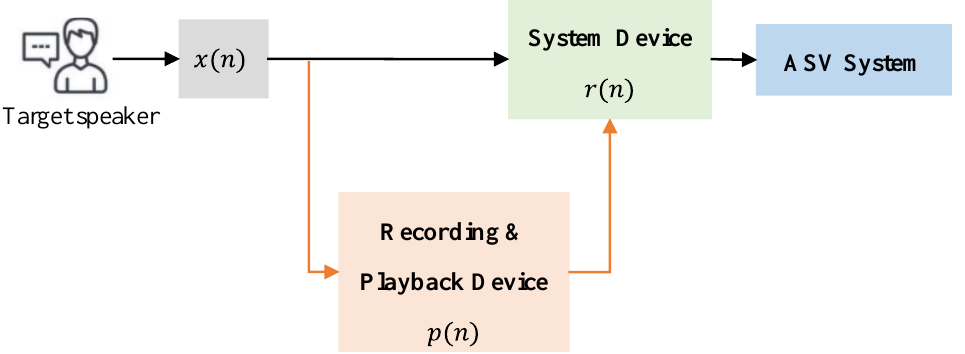
Figure 4. High sampling rate replayed data collection process.